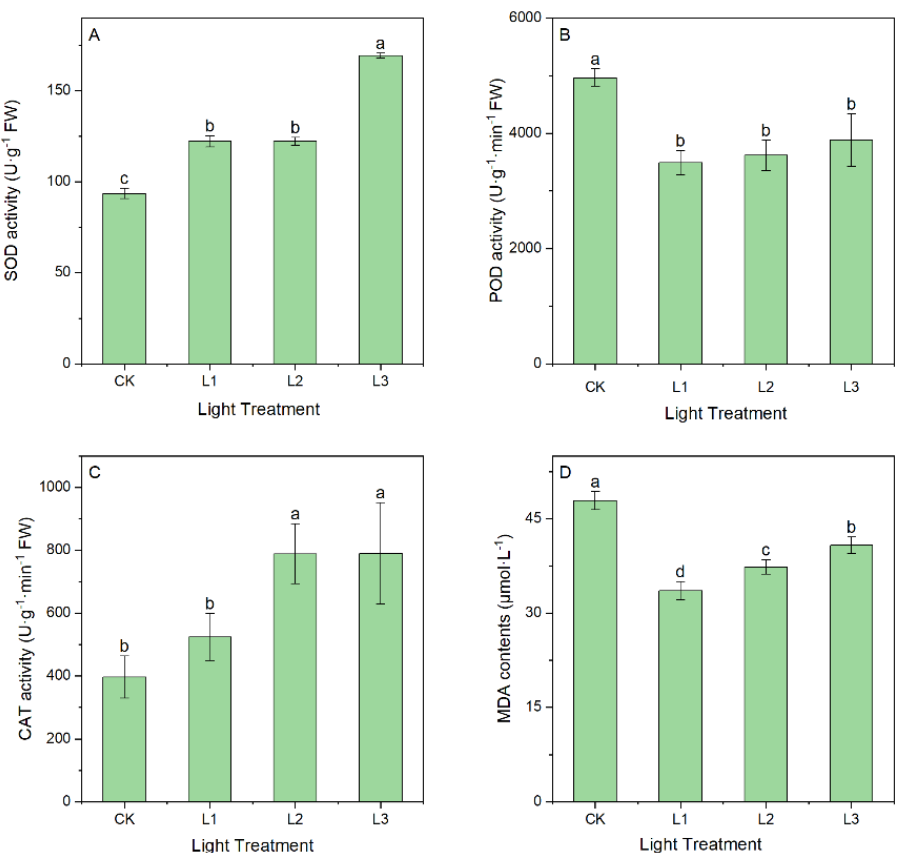
Figure 2. SOD activity ( A ), POD activity ( B ), CAT activity ( C ), and MDA contents ( D ) in leaves grown under different light intensities. Lowercase letters indicate significant differences under different light intensities ( p < 0.05).